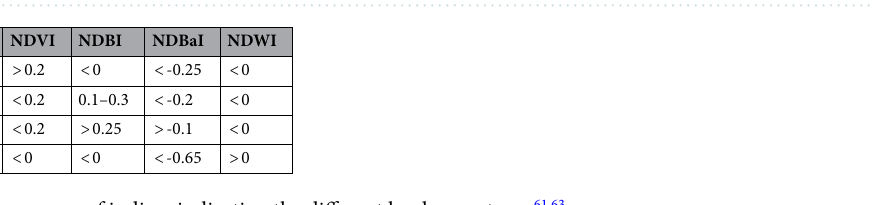
Table 1. The ranges of indices indicating the different land cover types 61,63